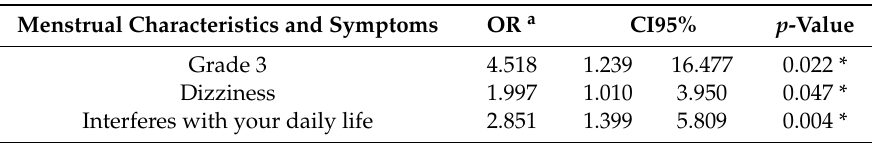
Table 3. Binary logistic regression to predict the perception of abnormal menstrual periods from menstrual characteristics and symptoms reported by